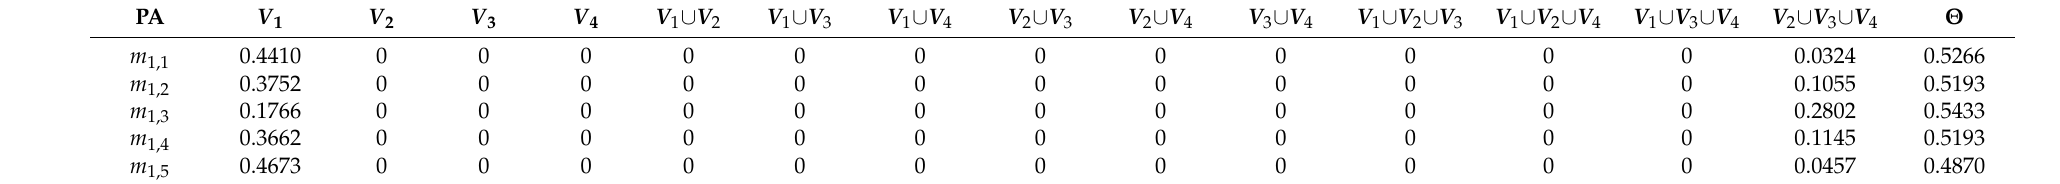
Table 2. Probability assignments of without crack-rest sub-classifier for an image without a crack.